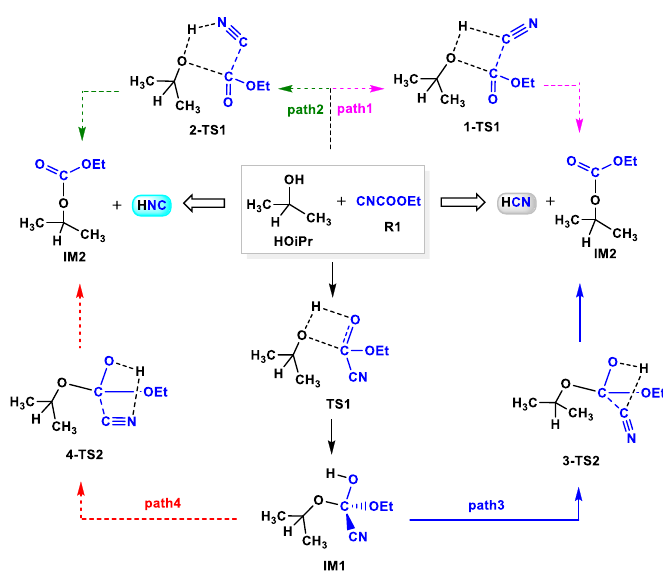
Scheme 2. Formation of HCN or HNC from the reaction between HOiPr and CNCOOEt.